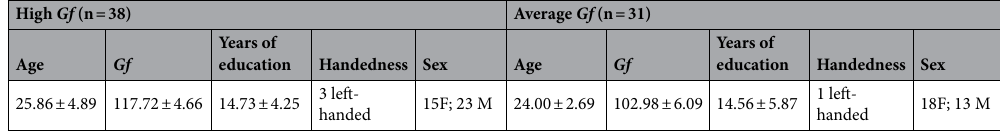
Table 1. Participants’ demographic data. Demographic data of the participants divided into the two experimental groups. Age, Gf and years of education indicate means ± standard